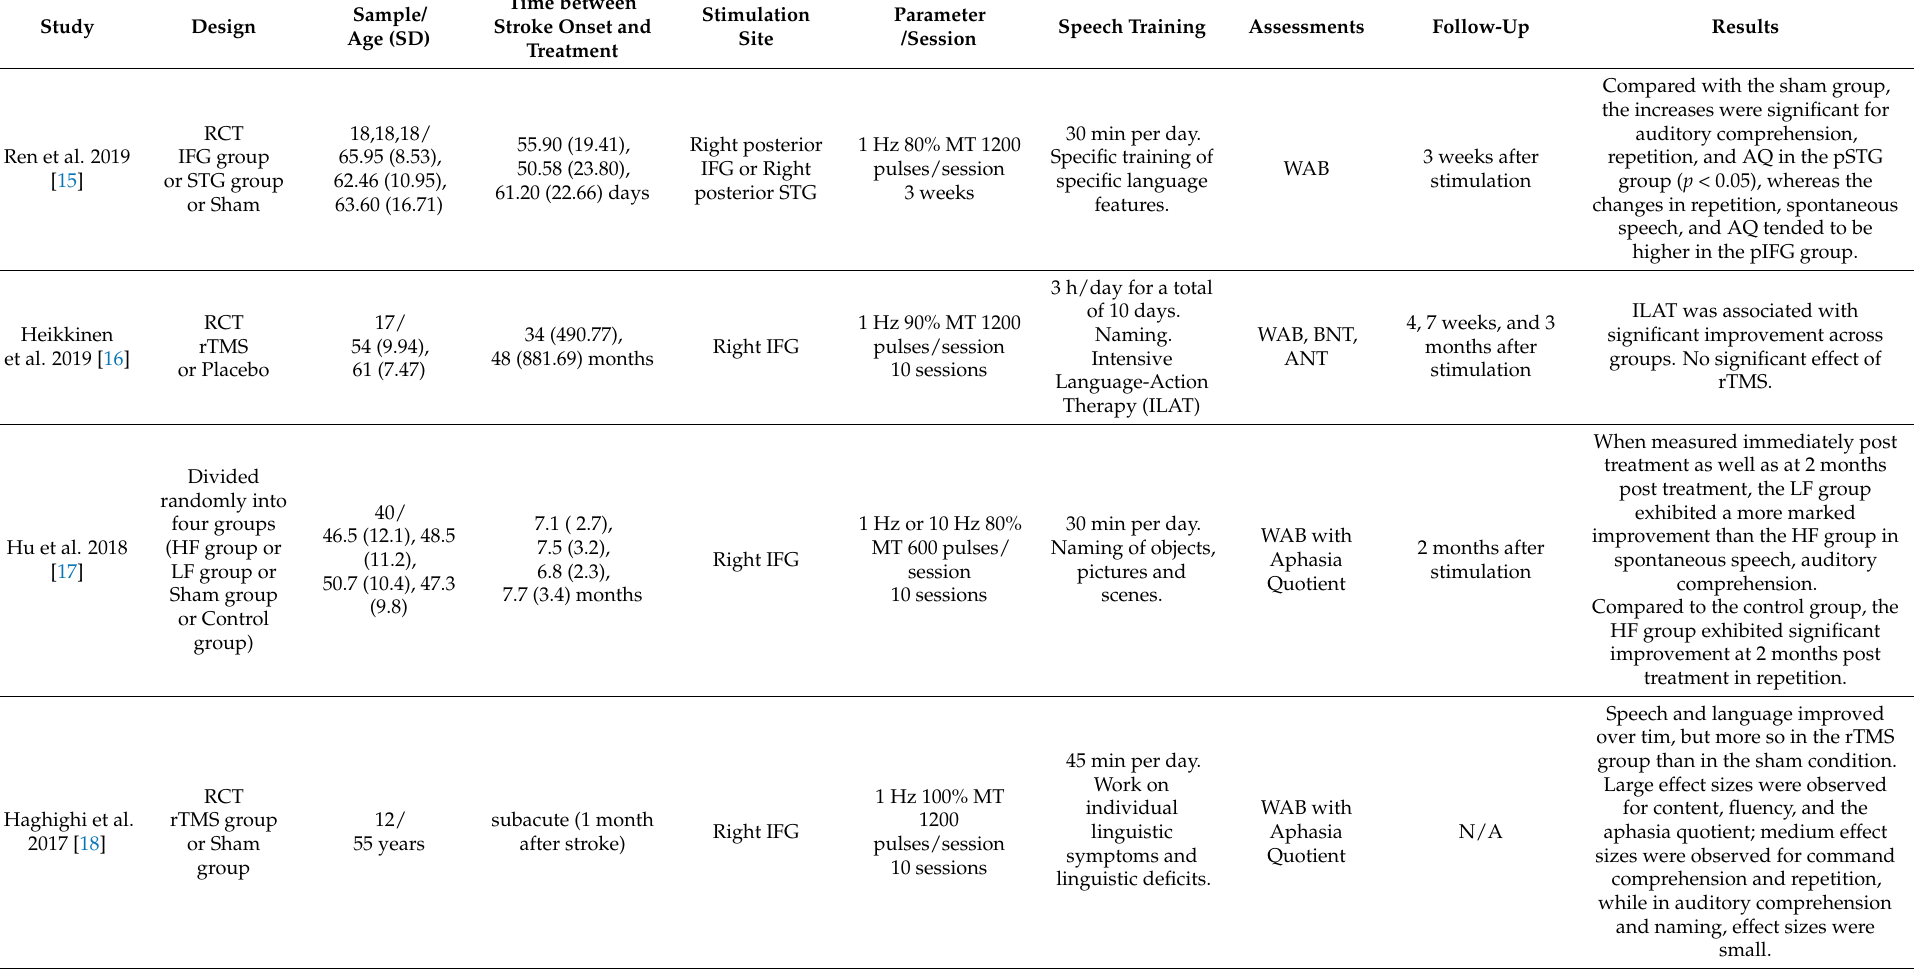
Table 1. Individual Study Characteristics, Treatment Characteristics, Assessments, and